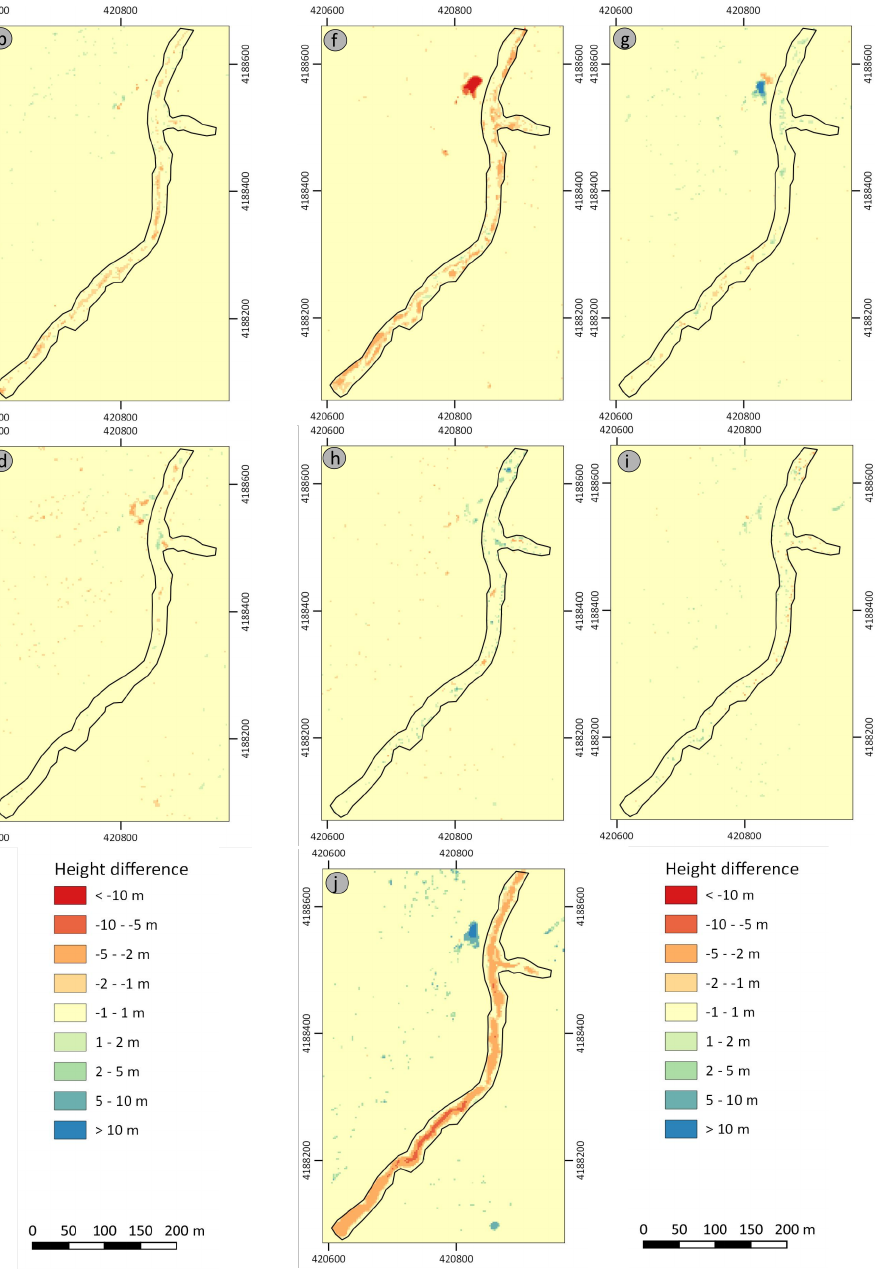
Figure 3 (continuation): f: 2011-2013; g: 2013-2016; h: 2016- 2019; i: 2019-2020; j: 1980-2020.